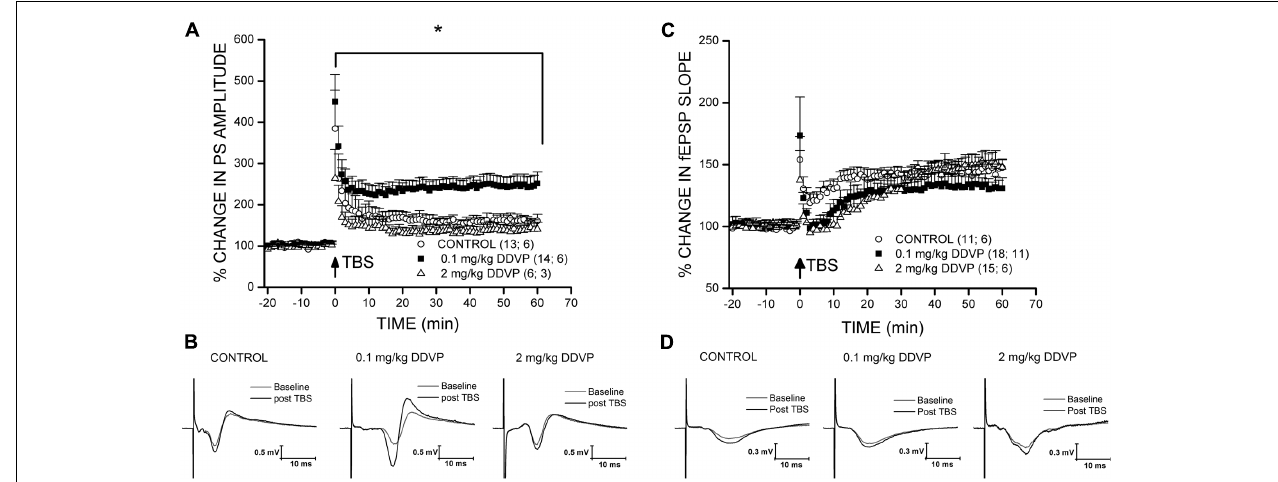
FIGURE 1 | Effect of sub-chronic DDVP treatment on LTP elicited in the stratum pyramidale and stratum radiatum of the rat hippocampus. For each experiment, the percentage potentiation was calculated with respect to the mean of the baseline response. The number of slices and animals analyzed are indicated in parentheses besides each treatment condition. (A) LTP recordings in the stratum pyramidale of slices obtained from control animals (open circles), and animals treated with 0.1 mg/kg (black squares), or 2 mg/kg (open triangles) of DDVP. The animals treated with 0.1 mg/kg DDVP showed an enhanced LTP relative to the control animals ( ∗ p < 0.05, unpaired t -test). (B) Representative traces of population spikes (PS) before (gray traces) and after TBS (black traces) for each condition. (C,D) Long-term potentiation recordings in the stratum radiatum . The symbols used are similar to those in (A,B) .